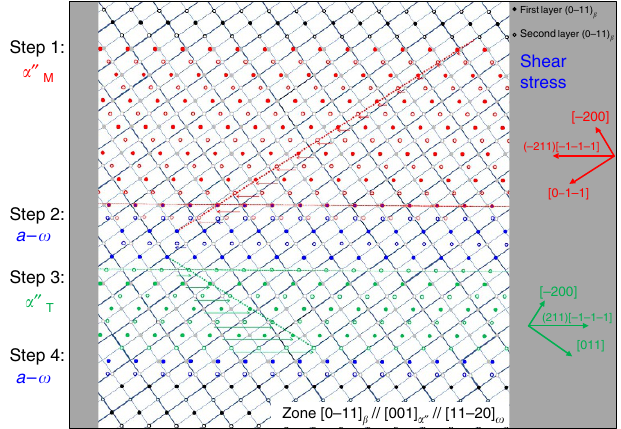
Figure 6 | Schematic representation of atomic movements associated with the complexion-mediated transformation upon cooling. Open and solid circles represent the first and second layers of atoms viewed from [0–11] b orientation. Colour in the figure: black to b -phase; blue to a – o ; red to a 00 -matrix; green to a 00 -twin. For better clarity, only b -indexes are used here. The transformation starts from the top and propagates to the bottom during cooling as divided into four steps: Step 1 (formation of a 00 -matrix), Step 2 (formation of first a – o layer), Step 3 (formation of a 00 -twin) and Step 4 (formation of second a – o